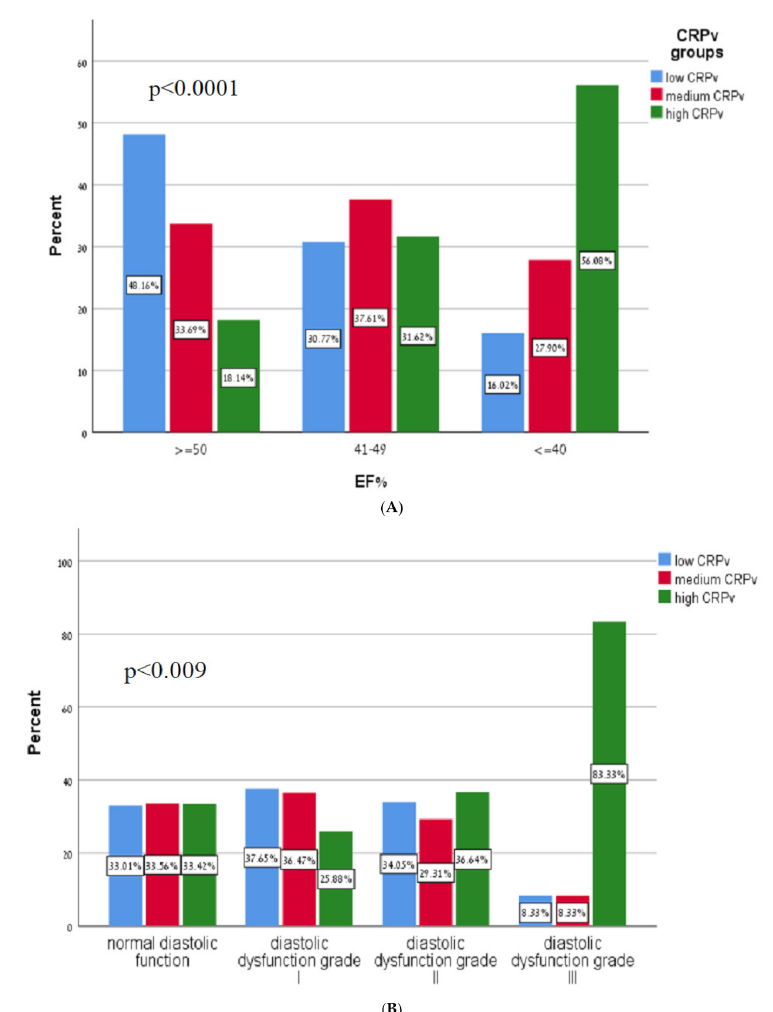
Figure 2. ( A ) Correlation of C-reactive protein velocity with systolic function. CRPv—C-reactive protein velocity, EF—Ejection fraction. ( B ) Diastolic function according to C-reactive protein velocity tertiles. CRPv—C-reactive protein